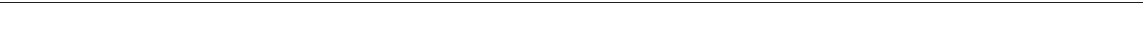
Fig. 5 S1P3 antagonists strengthen the blood – tumor barrier in vitro. a An in vitro model of the BBB was constructed with con fl uent brain endothelial cells on the luminal side of a coated porous membrane, brain pericytes on the abluminal side of the membrane, and astrocytes in the bottom of the abluminal side of the chamber. To create a blood – tumor barrier (BTB) model, spheres of 231-BR tumor cells were added to the bottom of the chambers. Barrier integrity was quanti fi ed by transendothelial electrical resistance (TEER), or diffusion of a drug (doxorubicin) from the luminal to abluminal side. Cells were cultured to con fl uence for 4 days, at which time antagonists ( b ) (EX26: 1 nM, JTE-013: 17 μ M, TY: 2 μ M, CAY10444: 10 μ M, and CYM50358: 25 nM) or vehicle were added. In BBBs and BTBs, both S1P3 antagonists selectively showed increased TEER, indicative of a tighter BBB ( c ) and BTB ( d ) ( n = 5). TY-52156 and CAY10444 decreased permeability of 100 µ g mL − 1 doxorubicin signi fi cantly in BBB ( e ) and BTB ( f ) models ( n = 5). g After 24 h post-treatment with TY- 52156 and CAY10444, the membranes containing brain endothelial cells were removed and stained for VE-cadherin (red) (white arrows). Nuclei were DAPI stained (blue). Increased staining and membranous localization was observed with TY-52156 and CAY10444 (scale bar = 20 μ m). h The effect of vehicle, 2 µ M TY-52156 or 10 μ M CAY10444 on BBB TEER in cultures with or without astrocytes. Signi fi cant TEER elevation by TY-52156 and CAY10444 was dependent on the presence of astrocytes ( n = 4). For ( c – f ) and ( h ), Kruskal – Wallis test and Dunn ’ s multiple comparison test were performed. Graphs represent the median and the error bars the 95% con fi dence interval, from independent transwell BBB/BTB cultures ( n ) from multiple experiments. * P < 0.05, ** P < 0.01, ns non-signi fi